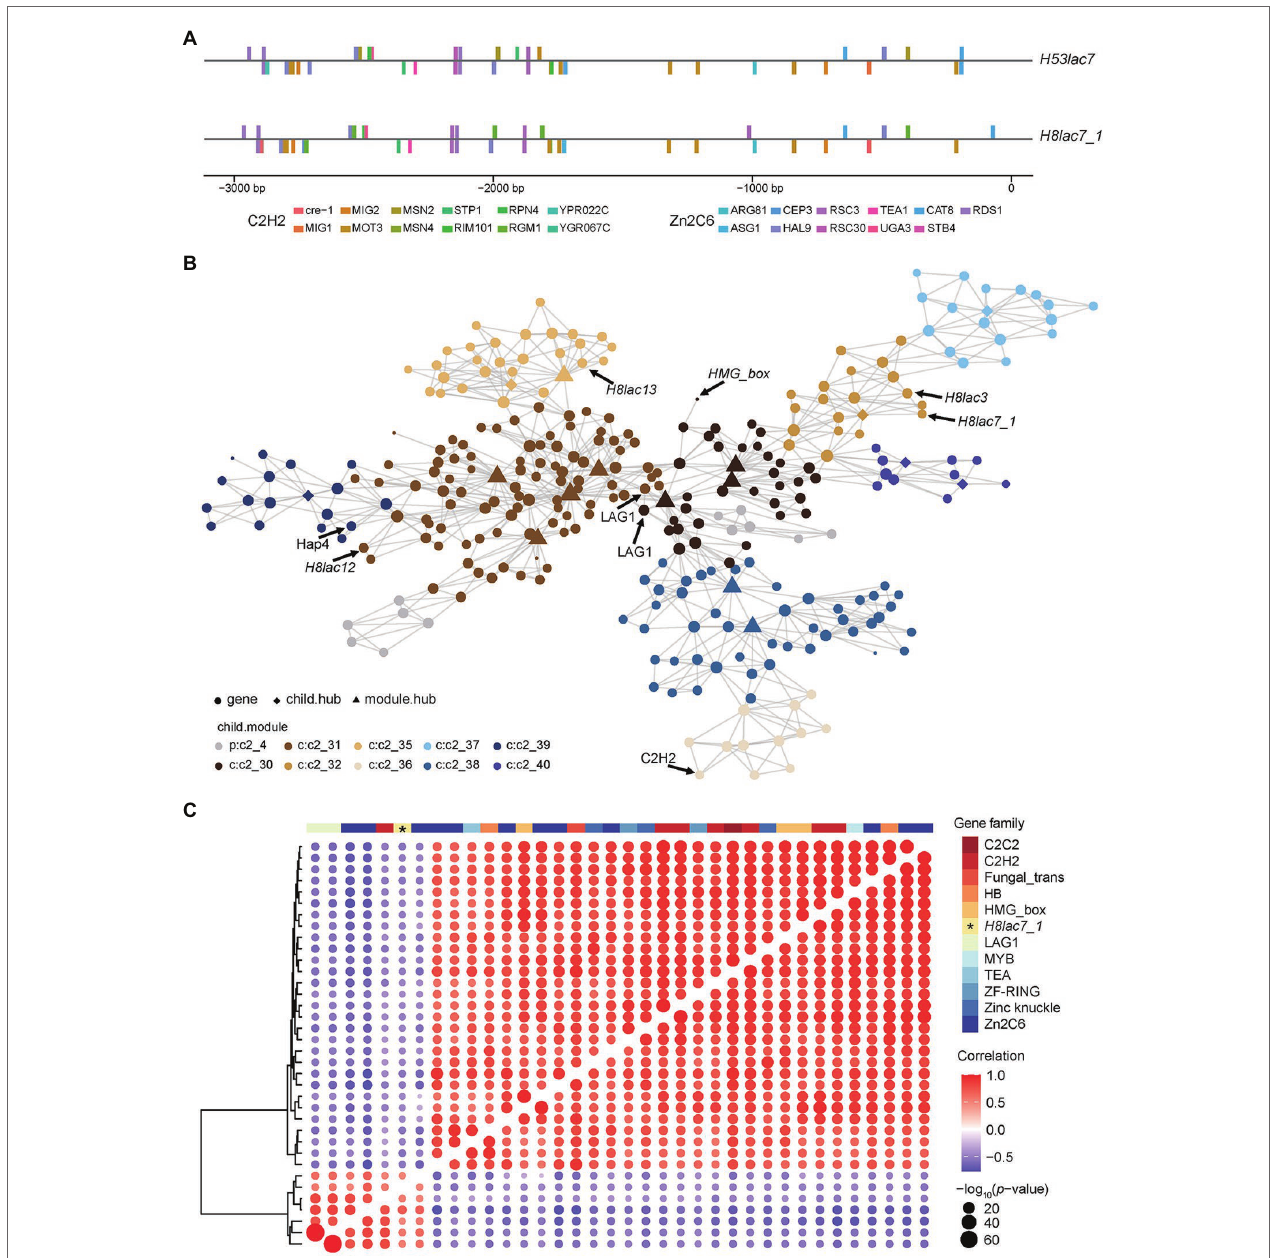
FIGURE 4 | TF binding site analysis and co-expression network of Gllac7 . (A) Predicted binding sites of zinc finger proteins in promoters of H53lac7 and H8lac7_1 . (B) The co-expression network of genes in the module containing Gllac7 . (C) Correlation of Gllac7 and